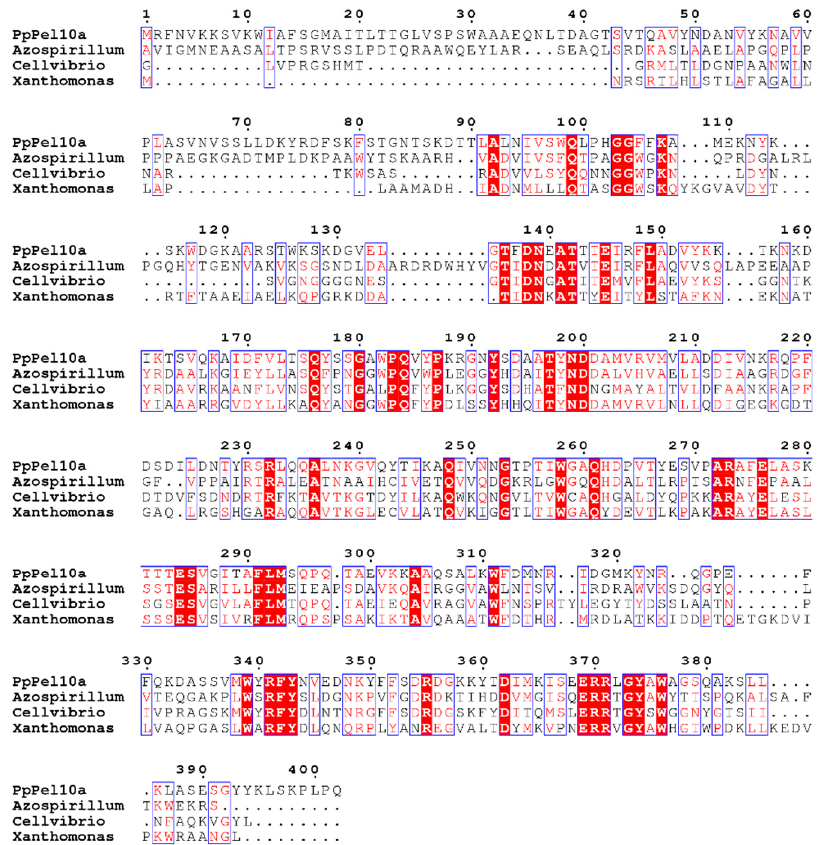
Figure 2. Alignment of amino acid sequence of PpPel10a with those of PL10 family pectate lyases from C. cellulosa (PDB ID: 1GXN), A. irakense (AF121904), and X. campestris (JQ723690).